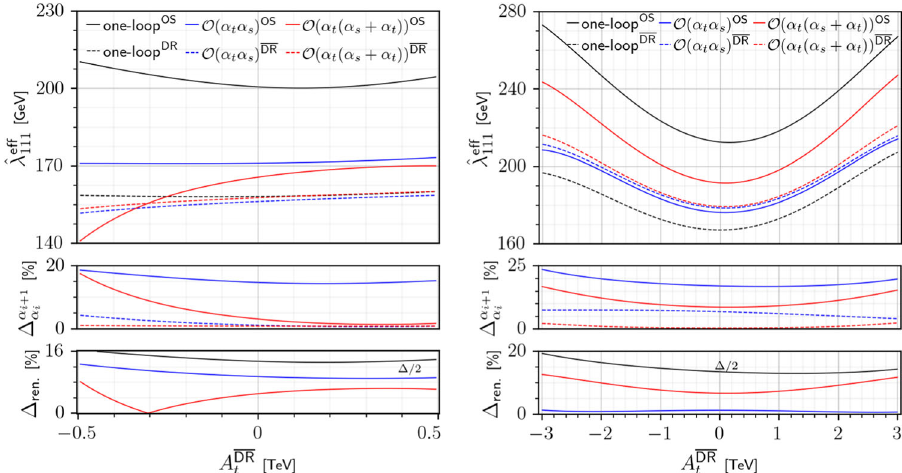
Fig. 2 Upper: Effective trilinear coupling ˆ λ eff of the 111 h u -dominated Higgs mass eigenstate as a function of A DR t for P2OS (left) and BP10 (right) at one-loop order (black), two-loop O (α t α s ) (blue) and two-loop O (α t (α s + α t )) (red) in the OS (full) and DR scheme (dashed). Middle: The relative correction as defined in Eq. (39). Lower: The relative renormalisation scheme dependence as defined in Eq. (40) for all three loop orders. The label (cid:11)/ 2 refers to the black